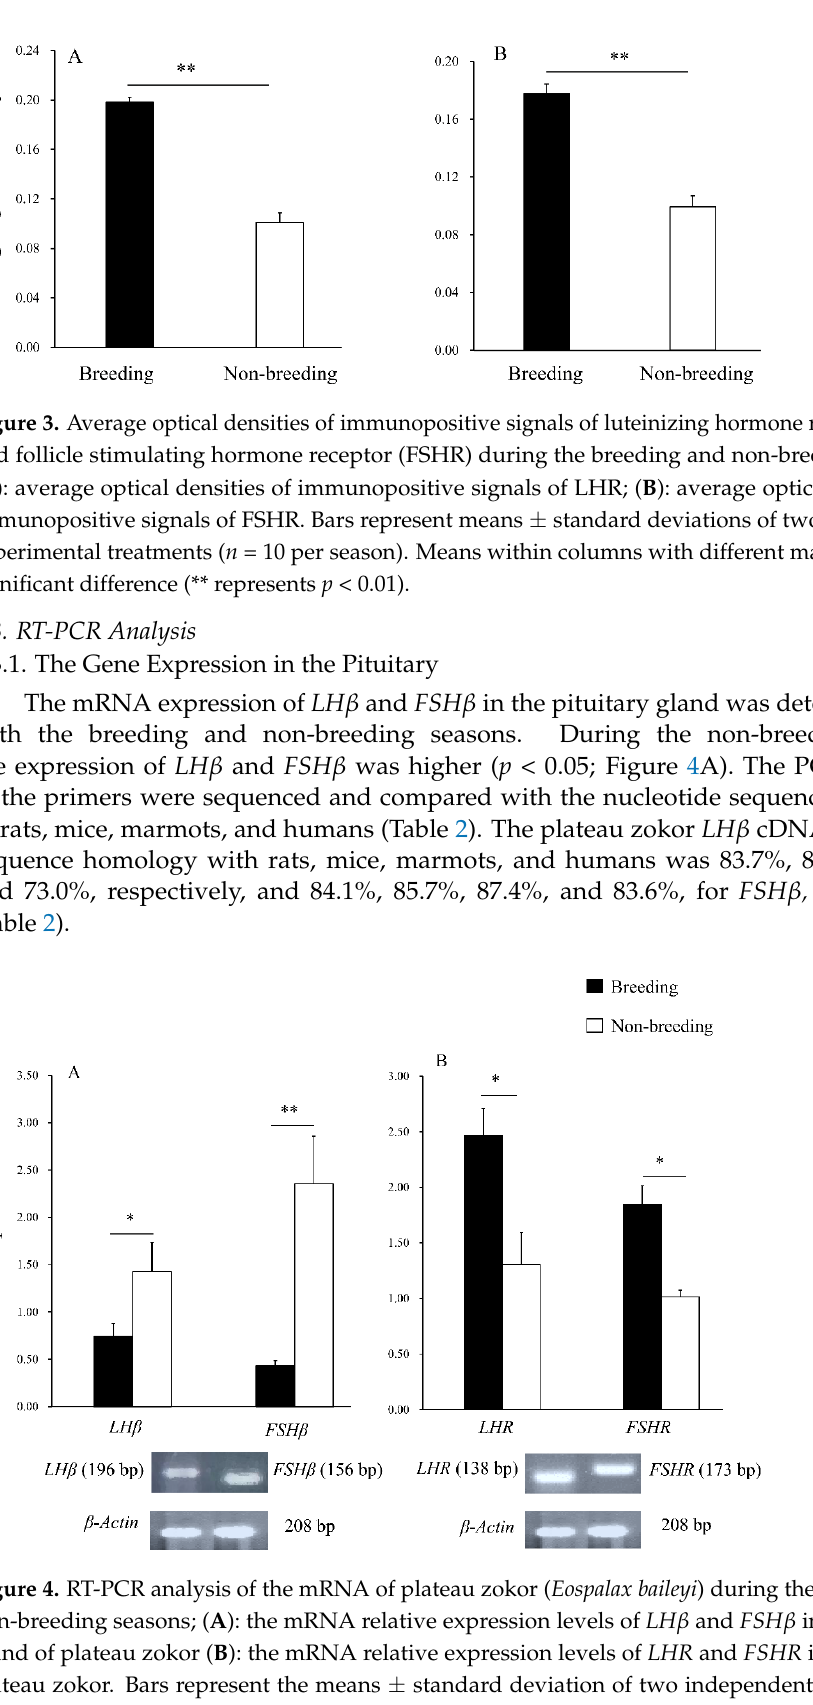
7 of 13 Figure 2. Immunohistochemistry results of luteinizing hormone receptor (LHR) and follicle stimu- lating hormone receptor (FSHR) in the testes of plateau zokor ( Eospalax baileyi ) during the breeding and non-breeding season. ( A , D ): the immune localization of LHR in the testes of plateau zokor, ( B , E ): the immune localization of FSHR in the testes of plateau zokor, and ( C , F ): the control using phosphate buffered saline (PBS) instead of the first antibody. Scale bars, 100 µm. SC, Sertoli cell; LC, Leydig cell; Spg, spermatogonia; pSpc, primary spermatocyte; sSpc, secondary spermatocyte; eSpd, elongated spermatid.